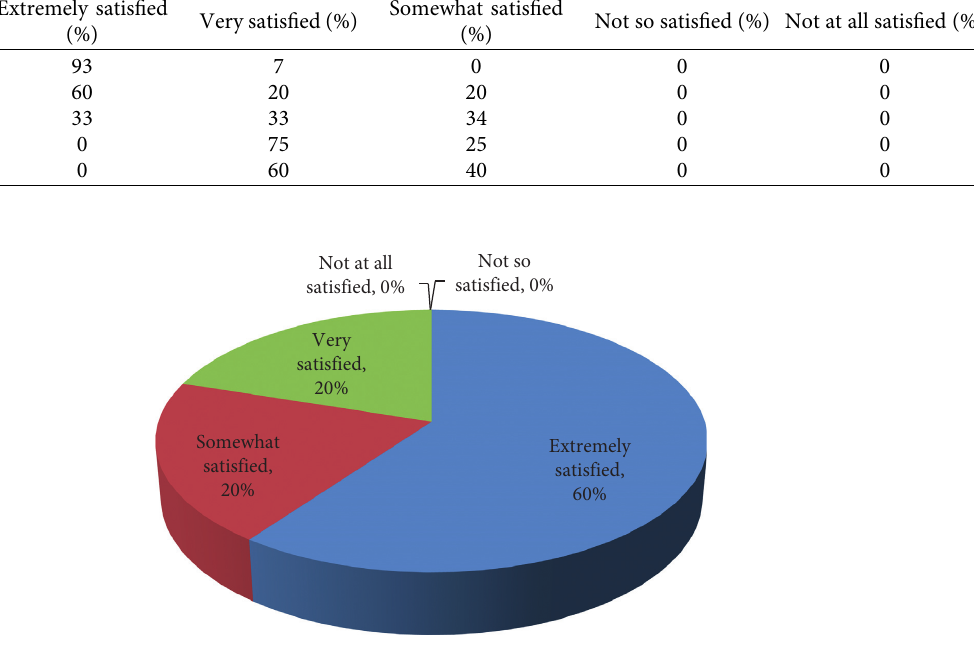
Figure 12: Graphical representation of model performance evaluation